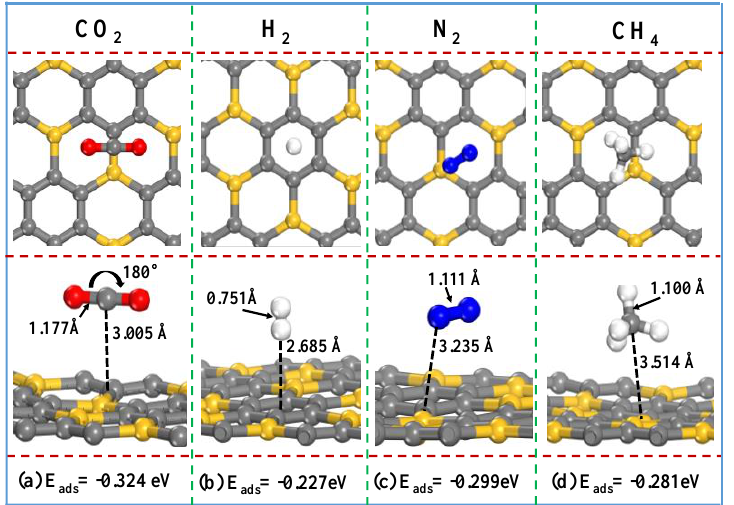
Figure 2. Top and side views of the stable adsorption configurations of different gas molecules adsorbed on the SiC 3 nanosheet without the injecting negative charges. ( a ) CO 2 , ( b ) H 2 , ( c ) N 2 , and ( d ) CH 4 adsorbed on the SiC 3